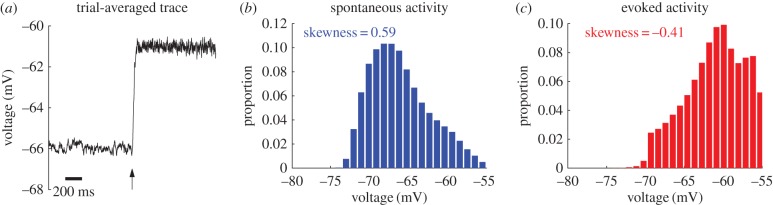
Membrane potential properties related to the synchronous and asynchronous states. (a) Membrane potential of a randomly chosen neuron within the region of input (RoI) averaged across all trials; the arrow indicates the time at which the stimulus is turned on, which coincides with a substantial rise in the mean value towards spike threshold (V
th = − 55 mV). (b) Histogram of the membrane potential values of the randomly chosen neuron during the spontaneous activity, aggregated across all trials; it has a positive skewness value of 0.59. (c) Histogram of the membrane potential values of the randomly chosen neuron within the RoI after stimulation, aggregated across all trials; it has a negative skewness value of −0.41.